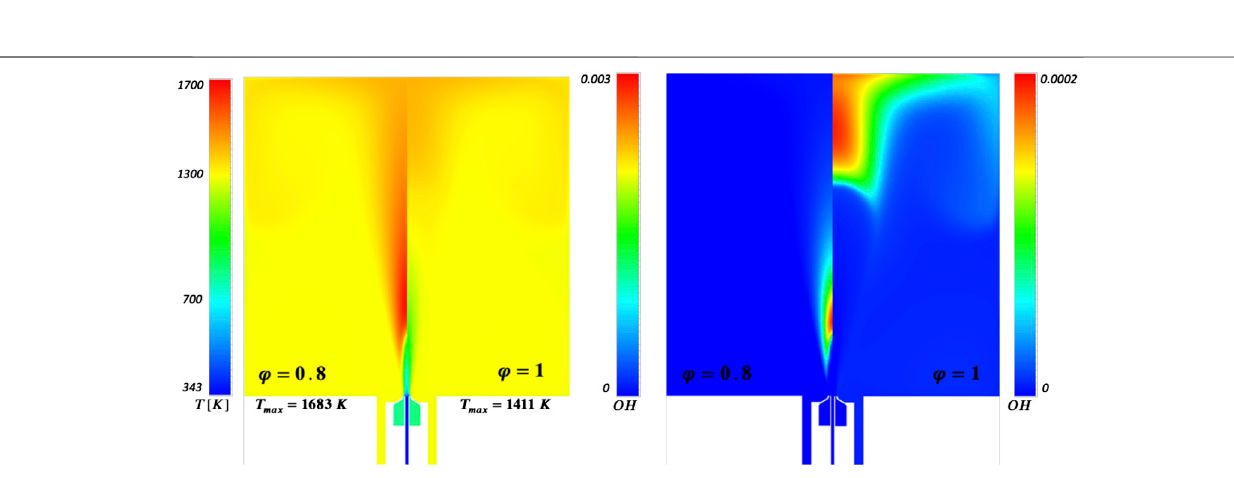
Frontiers in Energy Research |